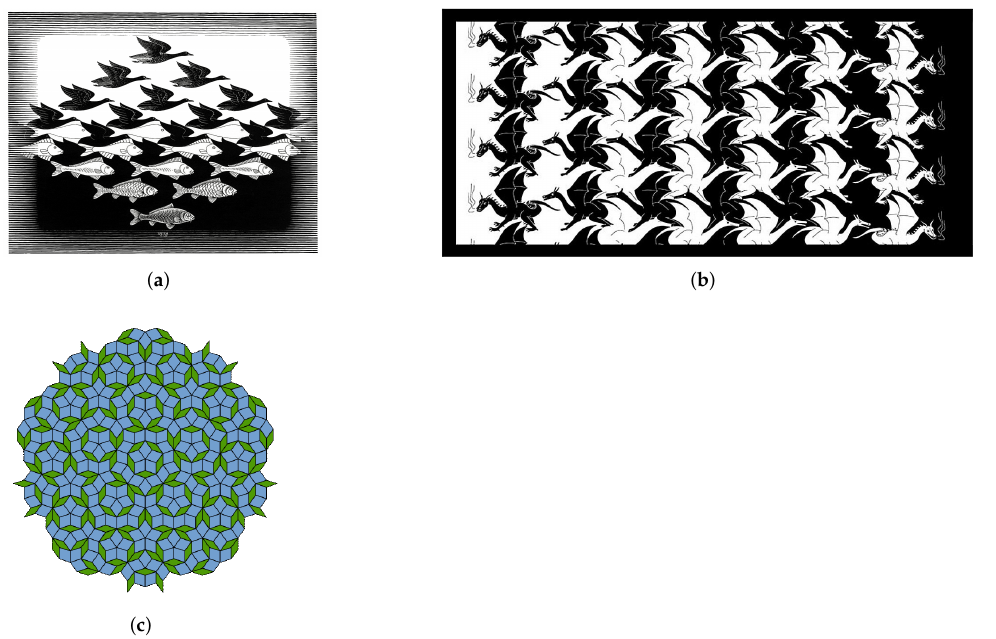
Figure 7. Some examples of early tessellations. ( a ) Sky and Water I (M.C. Escher), ( b ) Dragon tessellation (Robert Fathauer), ( c ) Penrose tiling (R.